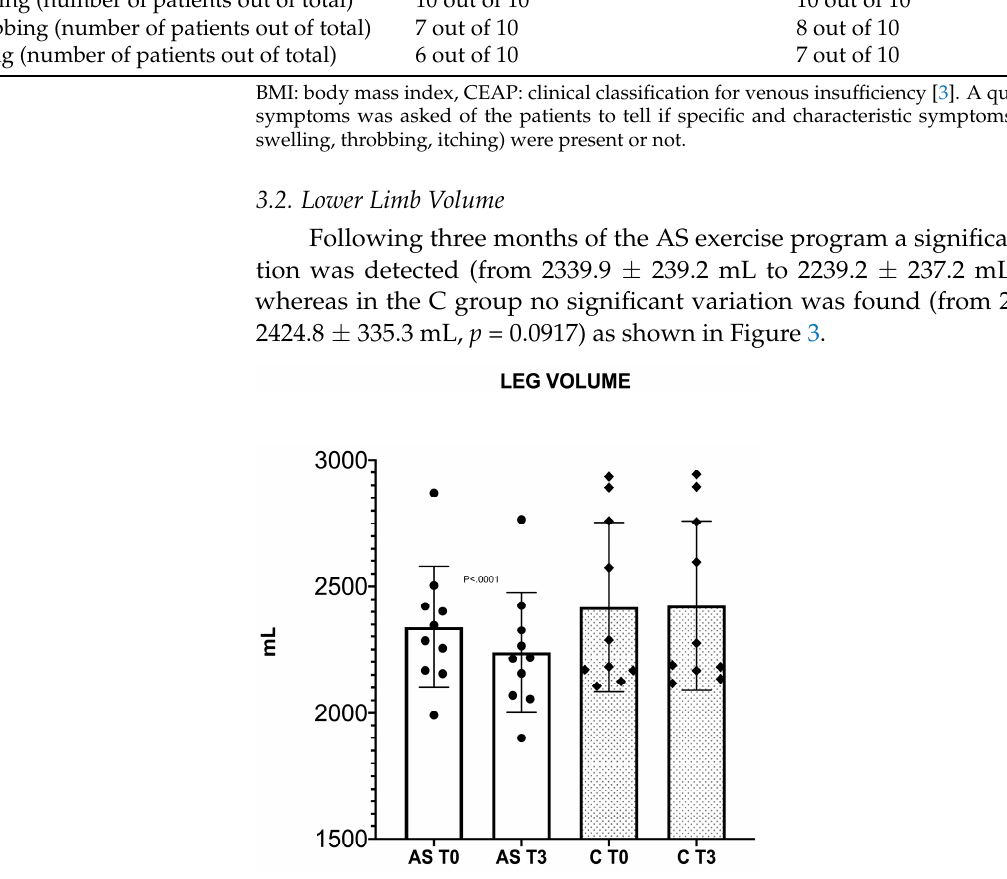
Figure 3. Leg volume significant reduction after three months follow-up in AS group (white histogram), while no significant changes in leg volume were recorded in the control group (dotted grey